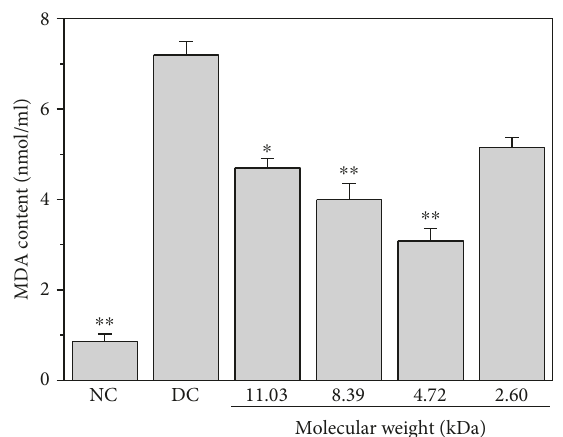
Figure 8: Changes of MDA content after the damaged HK-2 cells were repaired by APS with di ff erent molecular weights for 10 h. NC: normal control; DC: damaged control. Compared with the DC group, ∗ indicates p < 0 05 . ∗∗ indicates p < 0 01